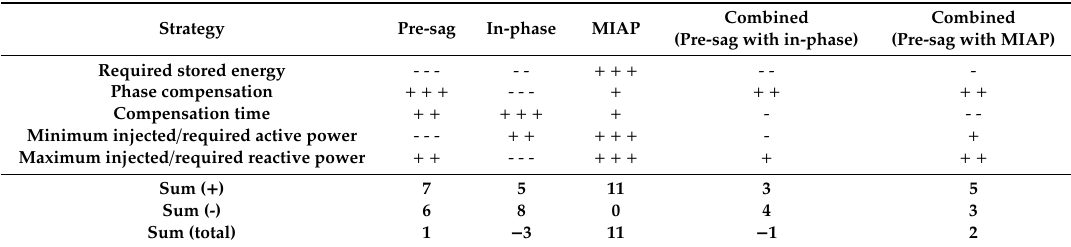
Combined Combined (Pre-sag with in-phase) (Pre-sag with MIAP)